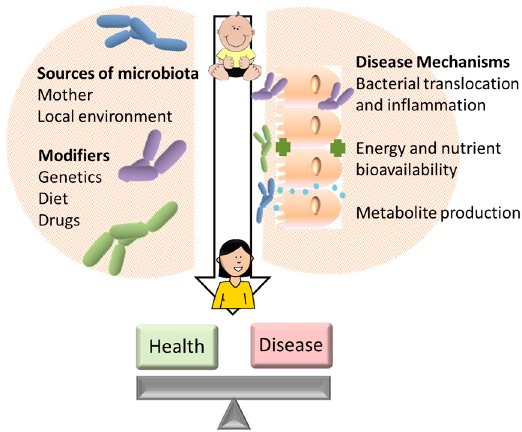
Figure 1. Determinants of microbiome composition, and potential mechanisms linking microbiota to